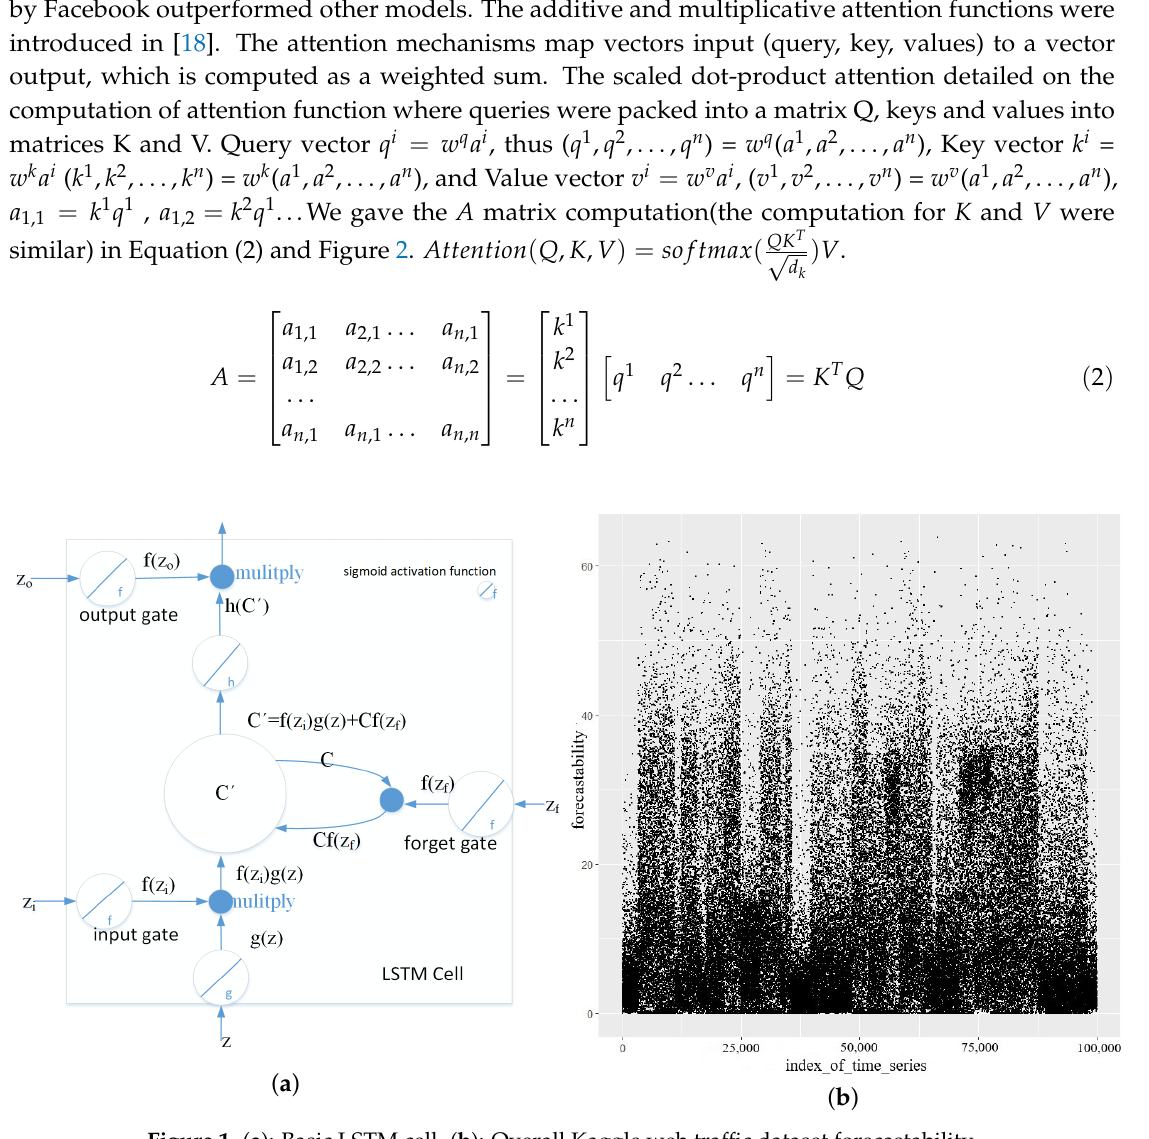
Figure 1. ( a ): Basic LSTM cell. ( b ): Overall Kaggle web traffic dataset forecastability.